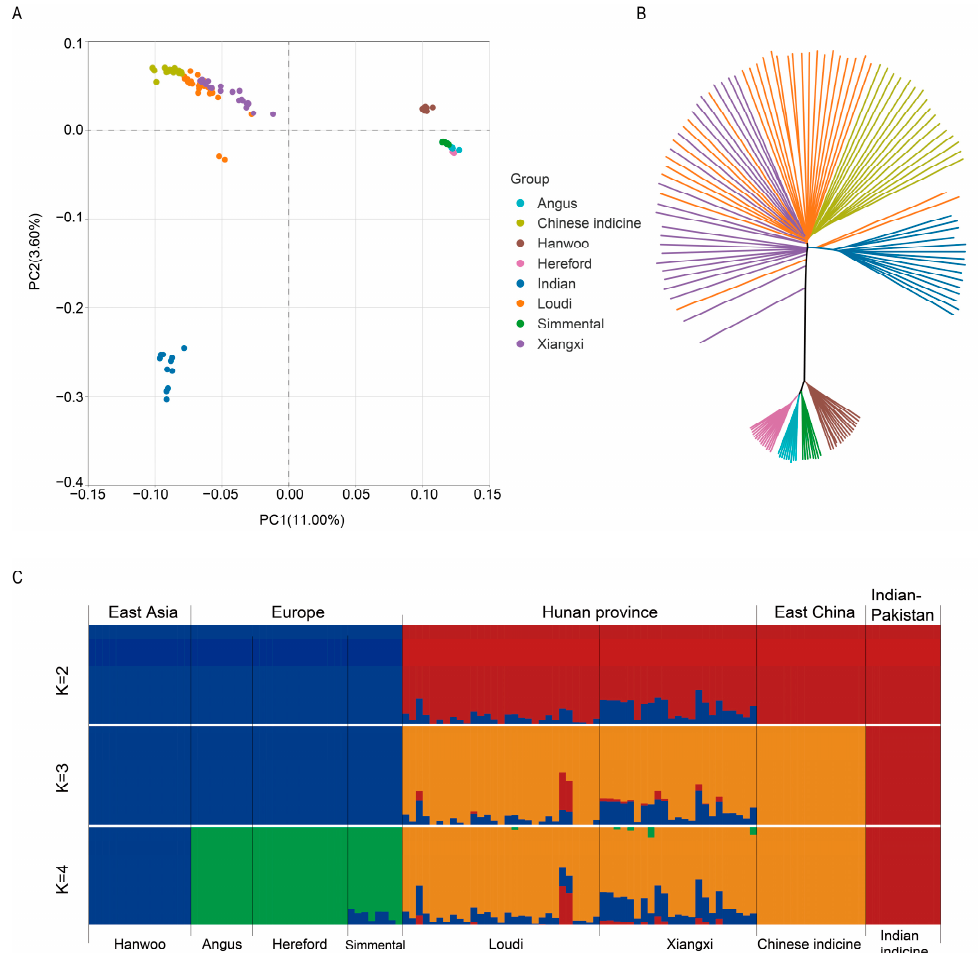
Figure 2. The structures of 125 samples from 8 populations. ( A ) PCA. Principal components 1 (11.00%) and 2 (3.60%) for the 125 cattle. ( B ) Phylogenetic tree. Phylogenetic relationships were estimated using the neighbor-joining method. ( C ) Genetic structure of cattle using ADMIXTURE when K ranged from 2 to 4. When K = 4, the CV error is the smallest.